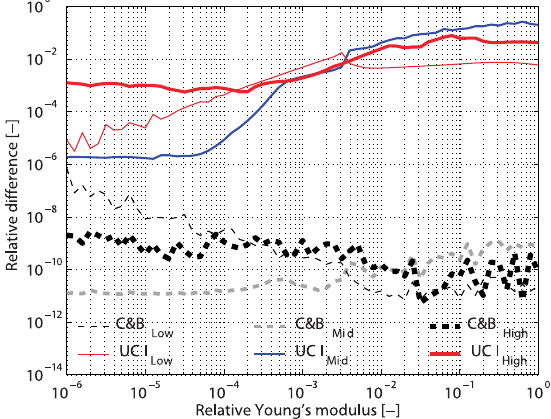
Fig. 8. The total relative difference between the modal solutions and the direct solution for the three frequency bands, using all inner modes. Function of the stiffness of the “soft” contactors (function of relative stiffness). C&B method (dashed lines) UCI approach (solid